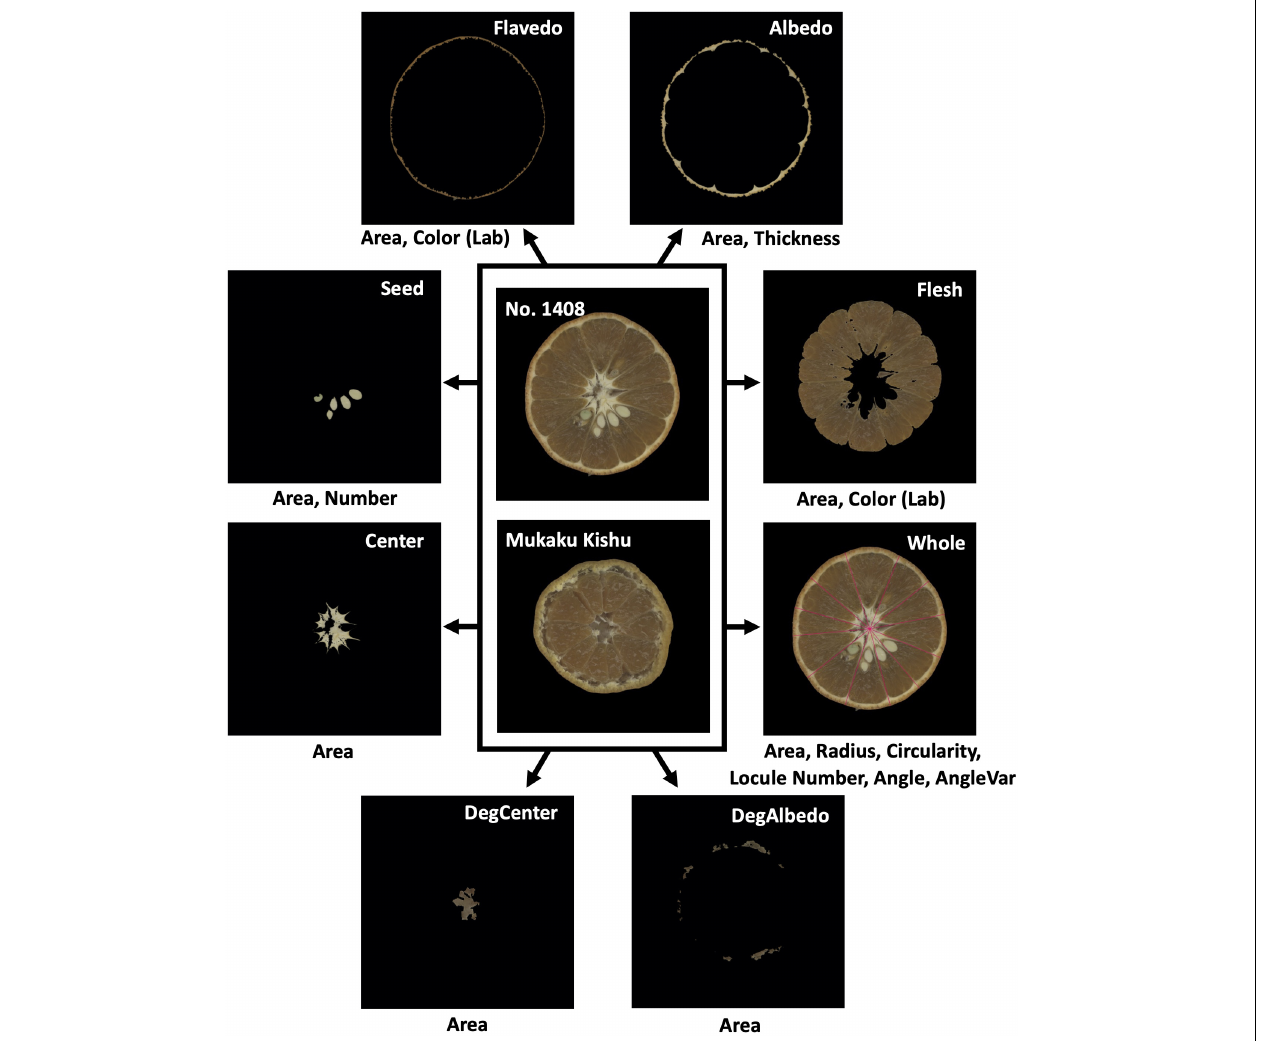
FIGURE 2 | Cross-sectional images of a citrus fruit used for the quantitative evaluation of morphological features. In each image, the top-right information indicates the fruit morphological region (DegCenter = degradation of center; DegAlbedo = degradation of albedo); the bottom information indicates the features evaluated from the morphological region. In total, 21 morphological features ( Table 1 ) were extracted and quantitatively evaluated from the images of citrus fruits using